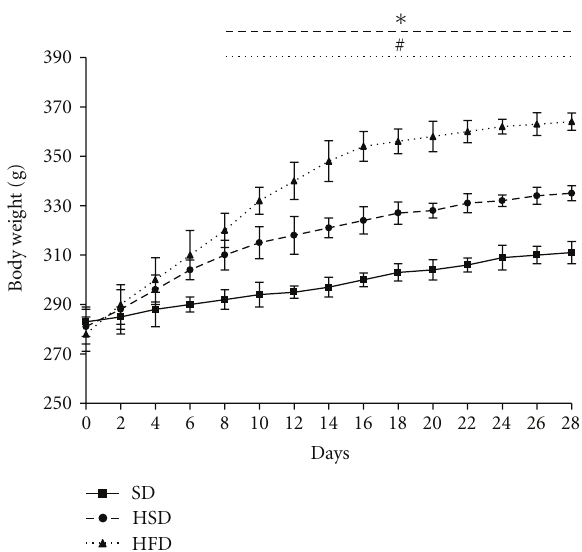
Figure 1: Evolution of body weight in SD, HSD, or HFD fed rats. Body weight was measured three times a week from the beginning of the feeding period till the end of week 4. Mean values ± s.e. obtained in each group are represented. ∗ Significant di ff erence between SD and HSD with P < 0.05 or more; # Significant di ff erence between SD and HSD with P < 0.05 or less.